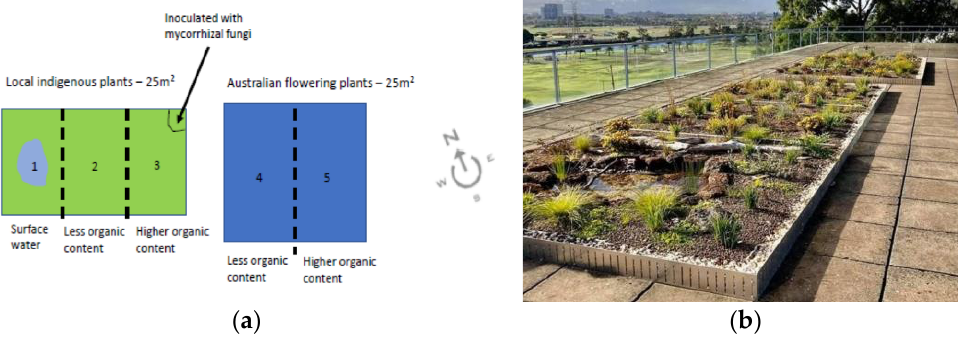
Figure 1. Details of green roof plots on Building M at Victoria University’s Footscray Park Campus: ( a ) Green roof design, ( b ) Actual constructed green roof.